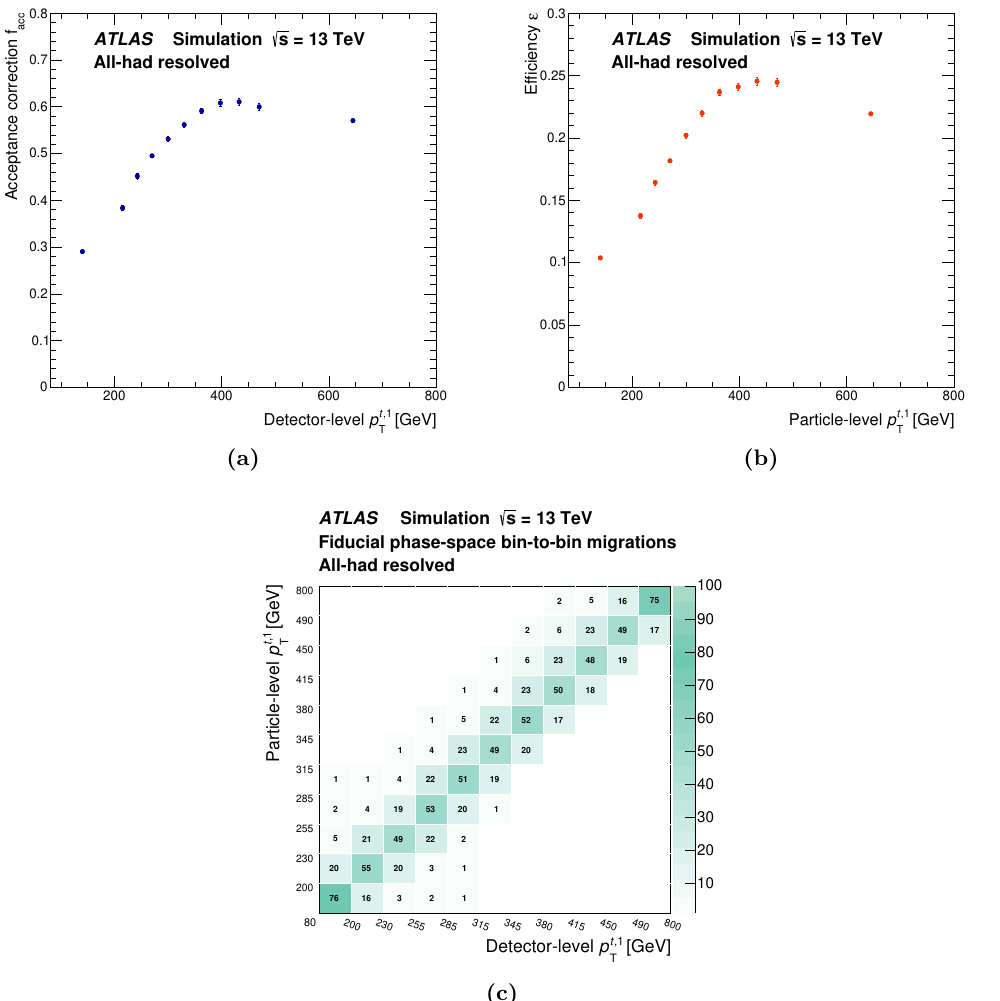
Figure 3 . The (a) acceptance f and (b) efficiency (cid:15) corrections in bins of detector- and particle- acc level p t, 1 , respectively, and (c) the particle-to-detector-level migration matrix (evaluated with the T MC t ¯ t signal sample) for the transverse momentum of the leading top